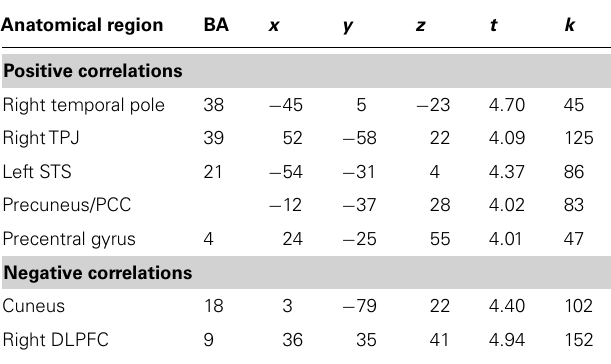
Table 4 | Neural regions activated in adolescents during affect labeling versus baseline that were associated with adolescents’ emotional